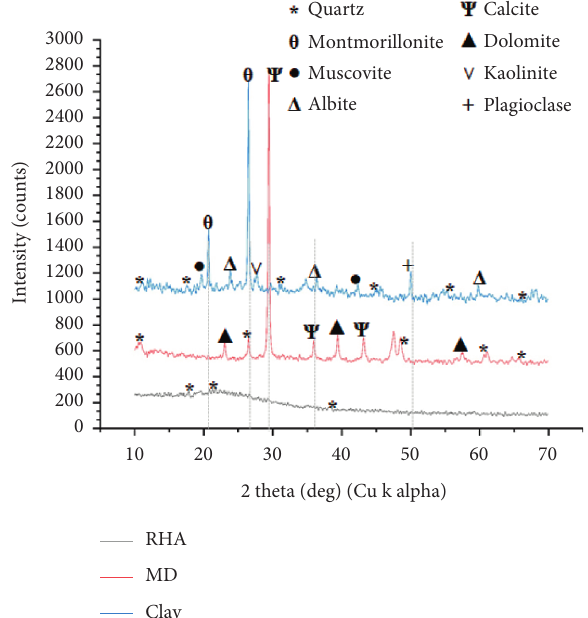
Figure 4: X-ray diffractographs of the expansive clay and stabilizer materials (marble dust and rice husk ash). Table 3: Sample nomenclature with expansive soil, marble dust, and rice husk ash percentages. Sample